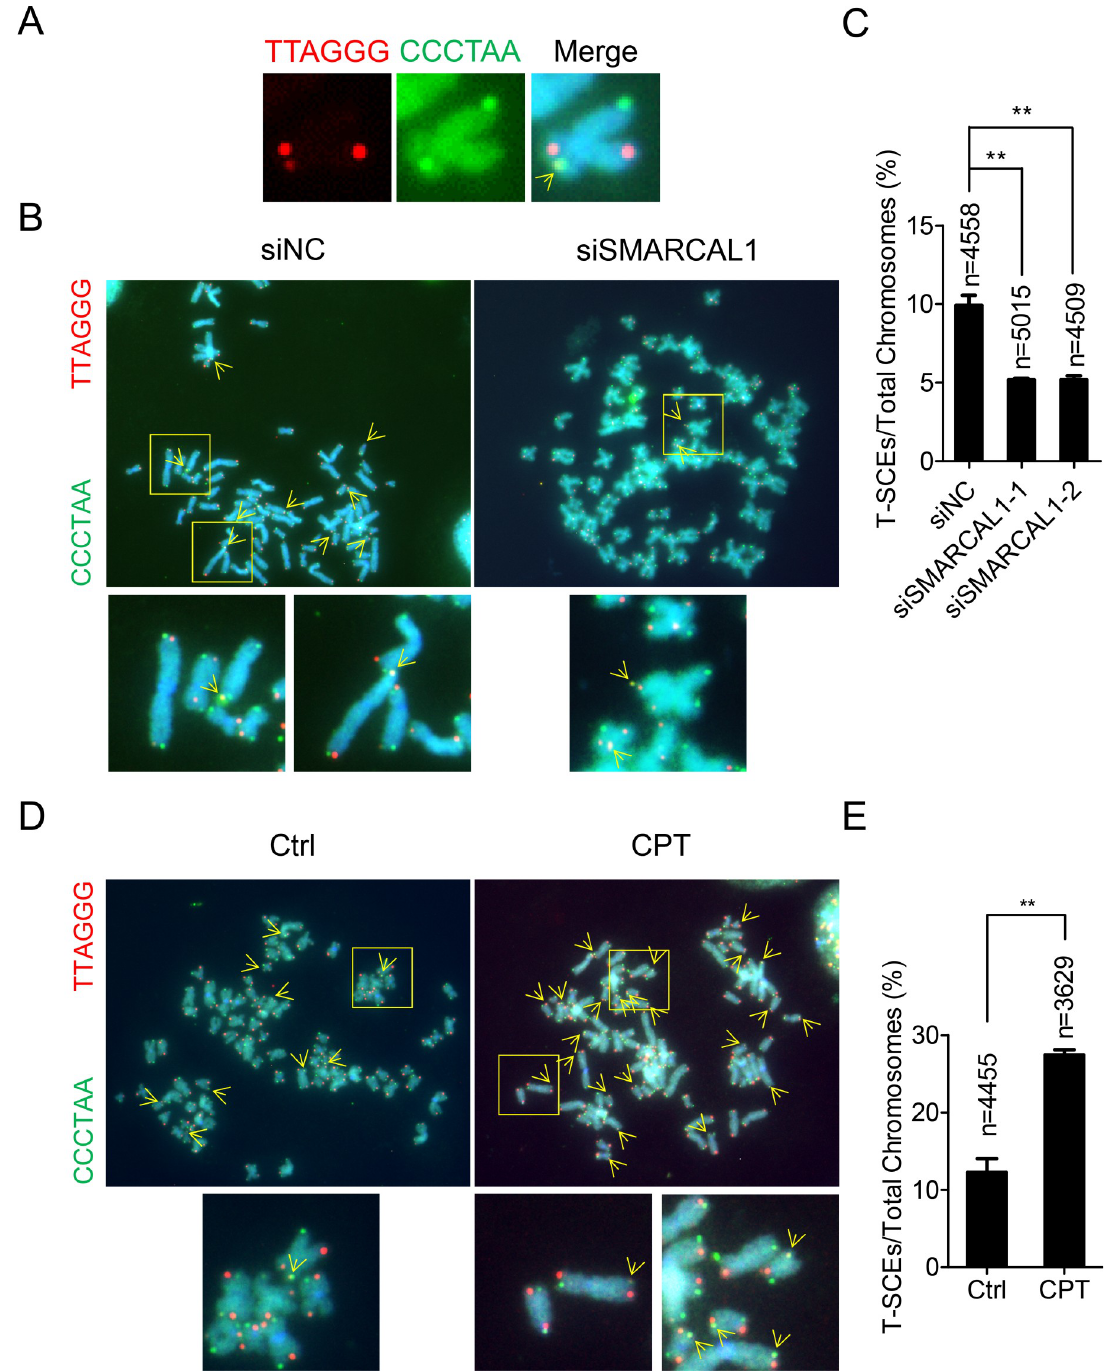
Fig 6. Telomeric HR is associated with replication fork regression. (A) Representative images showing C-strand (red) and G-strand (green) of telomeres on sister chromatins that are visualized by CO-FISH (chromosome orientation fluorescence in situ hybridization) assay. Yellow spot representing the occurrence of T-SCE was indicated by yellow arrows. (B) Representative images showing T-SCEs in U2OS cells depleted for SMARCAL1. (C) Quantification of (B). The number of chromosomes scored (n) in three independent experiments is indicated. Error bars represent the mean ± SEM of three independent experiments. Two-tailed unpaired student’s t -test was used to calculate P-values. �� P < 0.01. (D) Representative images showing T-SCEs in U2OS cells treated with CPT. (E) Quantification of (D). The number of chromosomes scored (n) in three independent experiments is indicated. Error bars represent the mean ± SEM of three independent experiments. Two-tailed unpaired student’s t -test was used to calculate P-values. �� P <